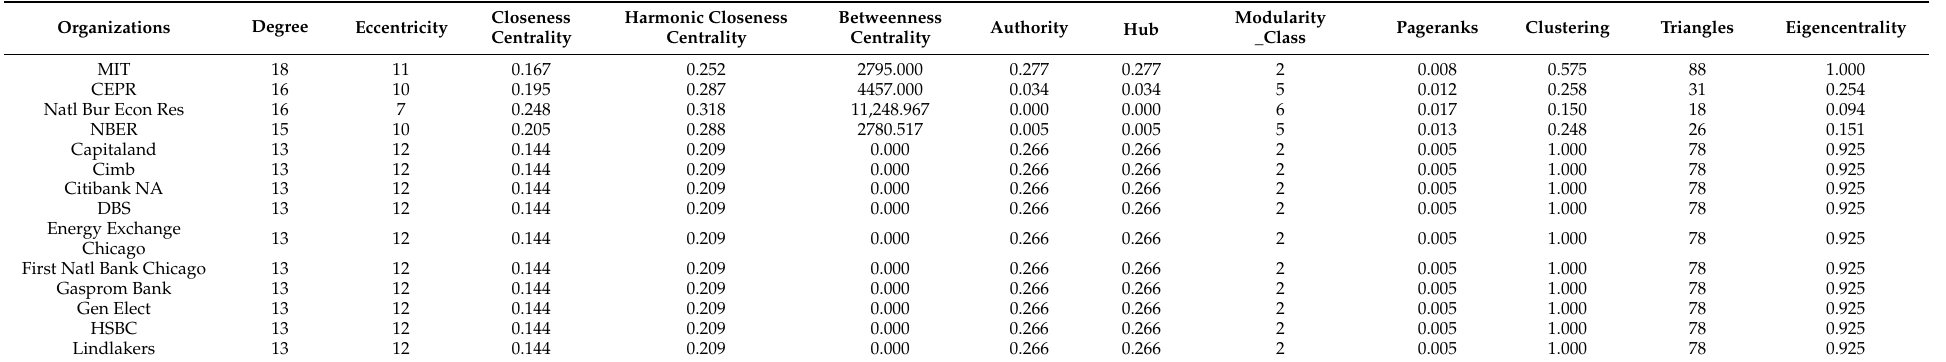
Table 6. Network, node, and edge statistics for co-authorship links and top 15 (degree) organization items, considering 1 as the minimum number of documents of an organization. Organizations